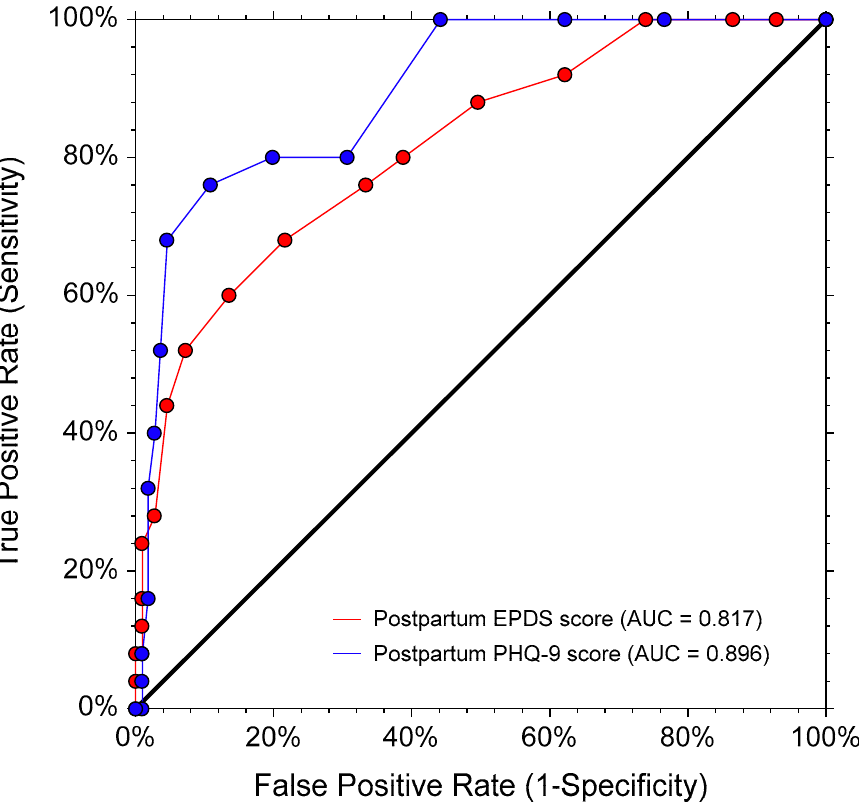
Figure 4. The receiver operating characteristic (ROC) curves of EPDS and PHQ-9 scores to differentiate disability (WHODAS score ≥ 10) from non-disability in 136 postpartum participants (postpartum data only). AUC (95% CI; p -value): EPDS = 0.82 (0.70, 0.89; p < 0.001), PHQ-9 = 0.90 (0.81, 0.94; p < 0.001). AUC difference (95% CI; p -value): 0.08 (0.16, 0.01; p = 0.044). AUC, area under the (receiver operating) curve (empirical estimate); EPDS, Edinburgh Postnatal Depression